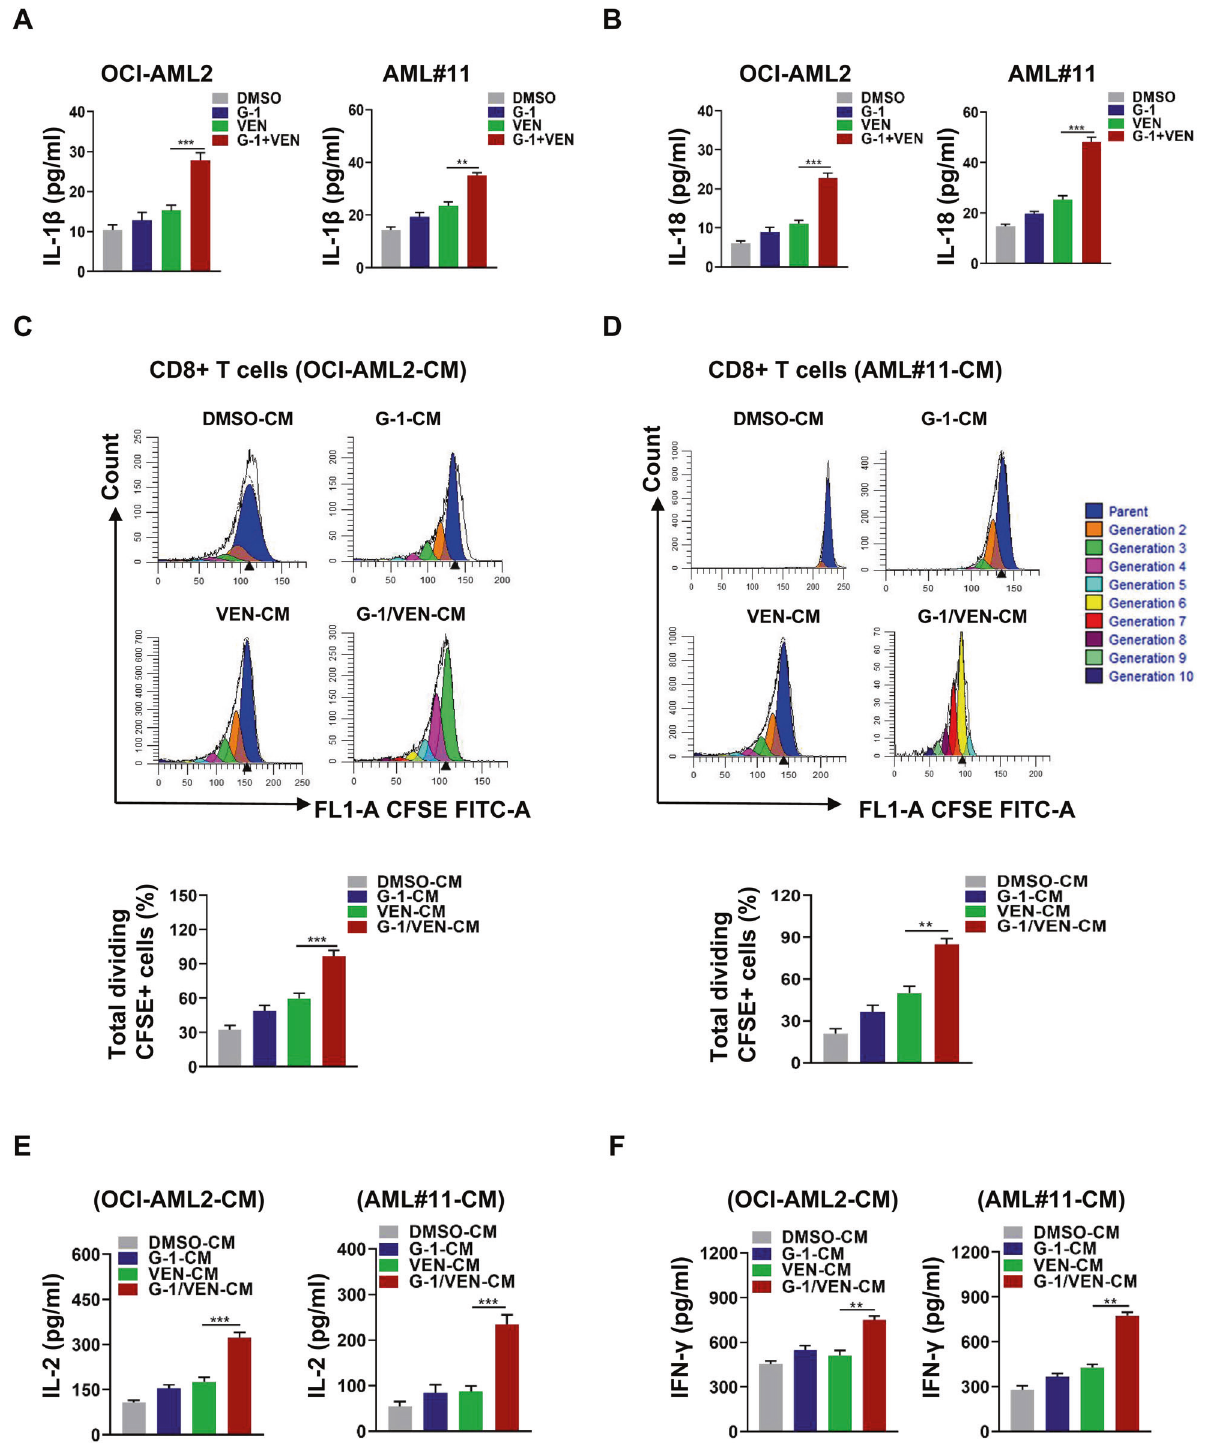
Fig. 4 G-1 and venetoclax synergistically improve the immune function of CD8 + T cells. CD8 + T cells pre-labeled with CFSE were incubated with CM from the OCI-AML2 cells or primary blasts treated with G-1 (1 μ M) and VEN (OCI-AML2; 0.02 μ M, AML#11; 0.2 μ M), alone or in combination for 24 h. A , B ELISA assay of IL-1 β and IL-18 levels in supernatant from cell cultures. C , D FCM analysis of CD8 + T cell proliferation. E , F ELISA assay of IL-2 and IFN- γ level in supernatants from cell cultures. The data are expressed as the mean ± SD ( n = 3). ** p < 0.01, *** p < immune function of CD8 + T cells in the leukemic microenviron- treatment facilitated MCL-1 degradation by activating p38-MAPK ment (Fig. 8). signaling, synergistically inducing leukemic apoptosis and GSDME- In the present study, reduced GPER levels were fi rst detected in dependent pyroptosis both in vitro and in vivo. Moreover, AML cases compared to HD. Several reports have demonstrated a pyroptosis-induced release of IL-1 β /18 further boosted the